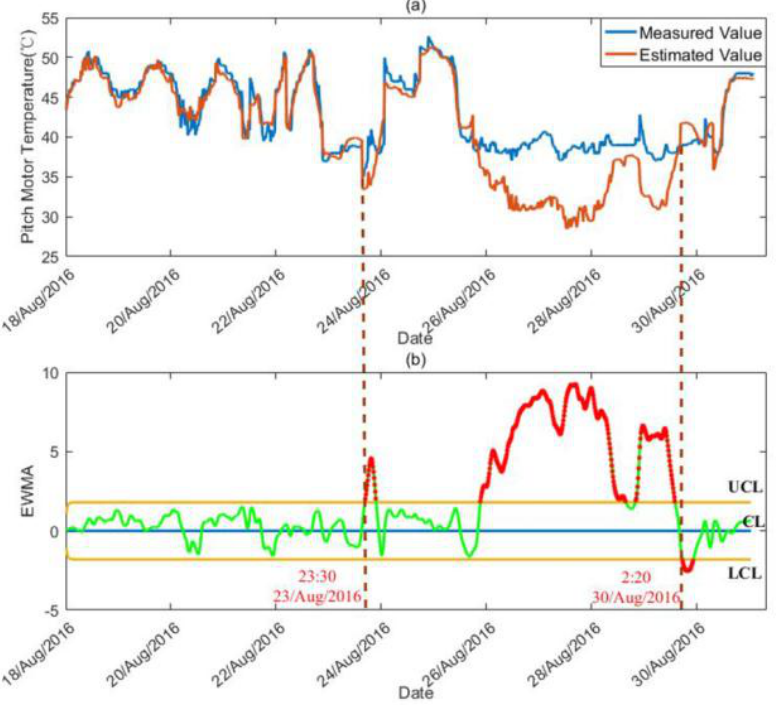
Figure 5. The monitoring results of Case 2. ( a ) The comparison of the model output and the actual temperature. ( b ) The residual analysis with the exponentially weighted moving average (EWMA) control chart.